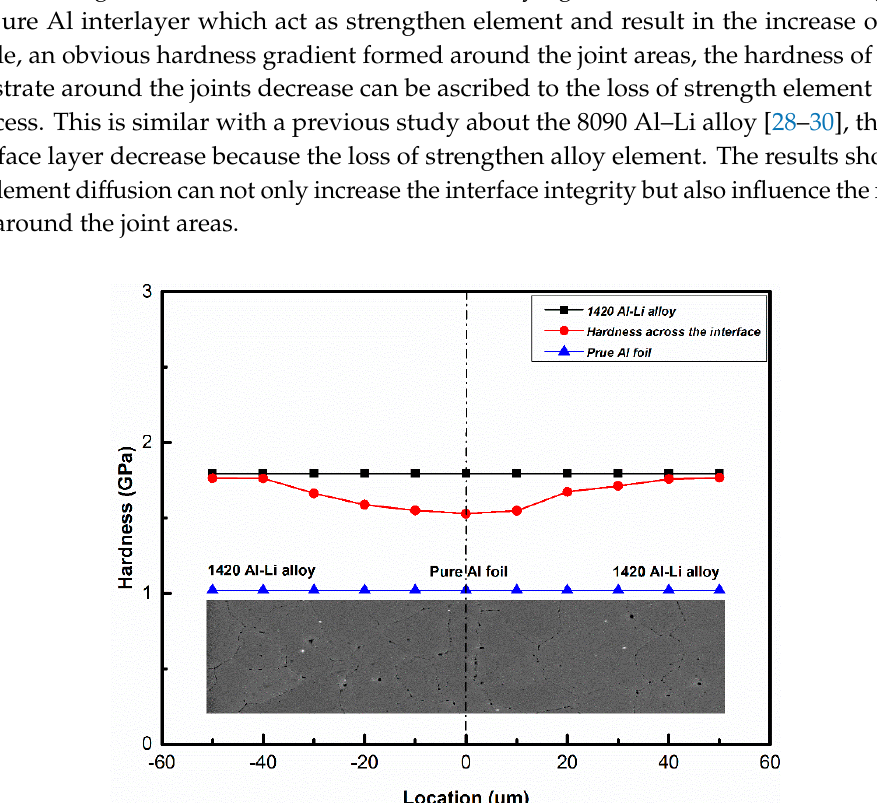
Figure 7. Nano-indention hardness distribution across the bond joint (520 °C–6 MPa–60 min).